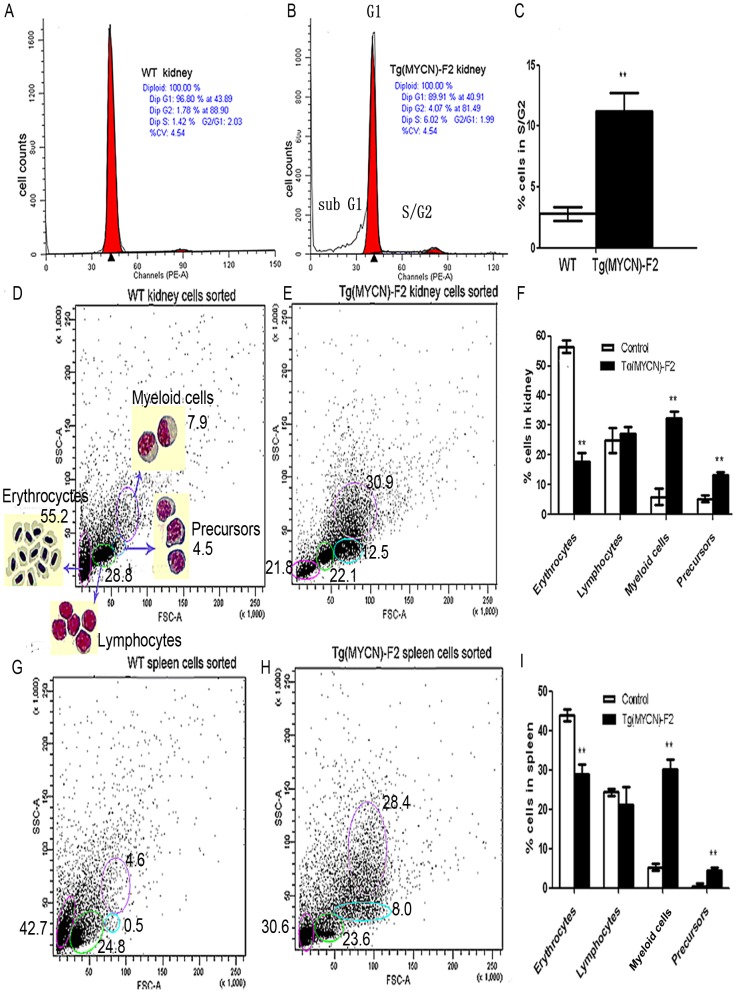

MYCN promoted cell cycle progression and increased the ratios of myeloid cells and its precursors.Single cell suspension from kidney of WT (A) and Tg(MYCN:HSE:EGFP) F2 generation (B) zebrafish was extracted at 60 dpf, treated with red blood cell lysis solution and stained with Propidium Iodide. Bars indicate the postion of modal DNA content peaks corresponding to the indicated G1 or S/G2 cell populations. It showed that MYCN increased the S/G2 ratio, histogram analysis in (C). In addition, elevated apoptosis was also detected in Tg samples as indicated by sub G1 peak (B). FACS analysed blood cells from kidney and spleen of WT (D, G) and Tg (E, H) fish at 60 dpf. Gated populations are as follows: erythrocytes, lymphocytes, myeloid cells, and blood cell precursors (morphologic feature was shown in D). All the detections repeated 3 times and analyzed in the two histograms (F, I) both indicated that myeloid cells and precursors were increased in Tg fish, correspondingly erythrocytes dramatically decreased, meeting the results of peripheral blood smear. **, P<0.01